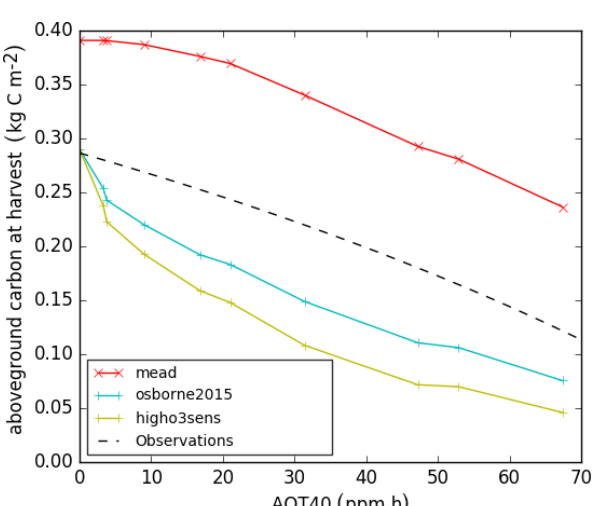
Figure 4. Black dashed line is the line of best fit from SoyFACE ob- servation, and the blue and green lines with crosses are the modelled output for each ozone concentration using the Osborne et al. (2015) tuning with Sitch et al. (2007) low and high sensitivity, respec- tively. The red line and crosses are the tuned parameters with Mead FLUXNET observation and SoyFACE ozone damage according to Table